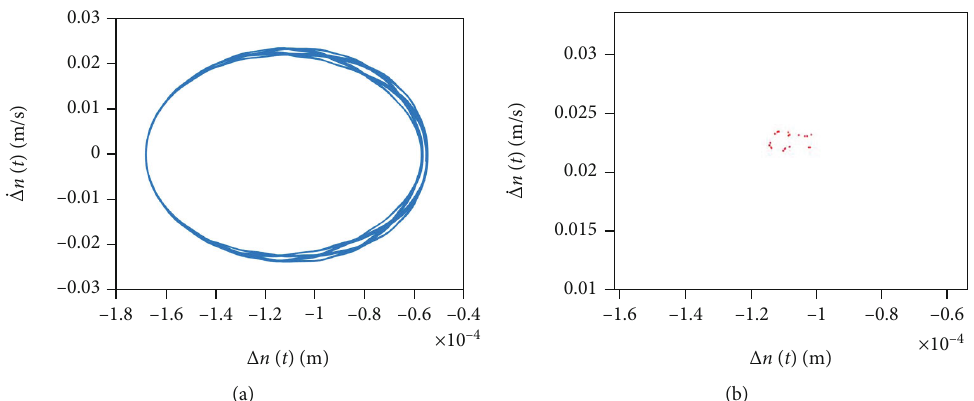
Figure 31: When the rotation speed of the system is 4100r/min: (a) relative displacement velocity and (b) the corresponding diagram of Poincare.